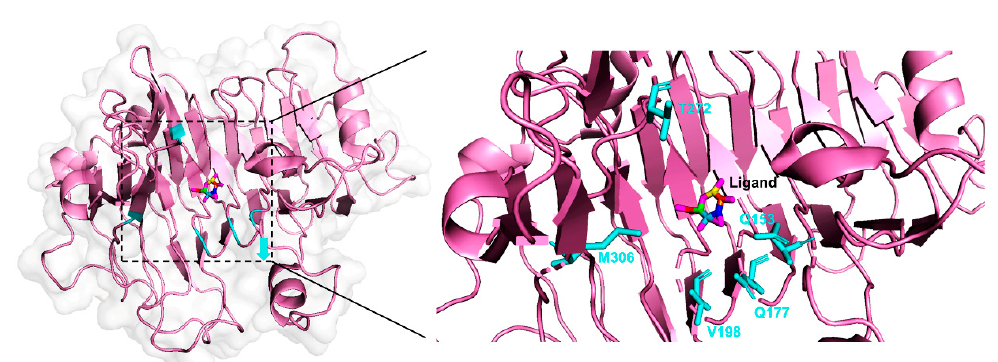
Figure 6. View of predicting effects of residue mutation on the catalytic efficiency of the ester hydrolysis reaction (Pectin Esterase A, PDB:1QJV). Regions of mutated sites that decrease catalytic efficiency are highlighted in cyan on the cartoon. Ligand is shown as sticks in the rainbow.